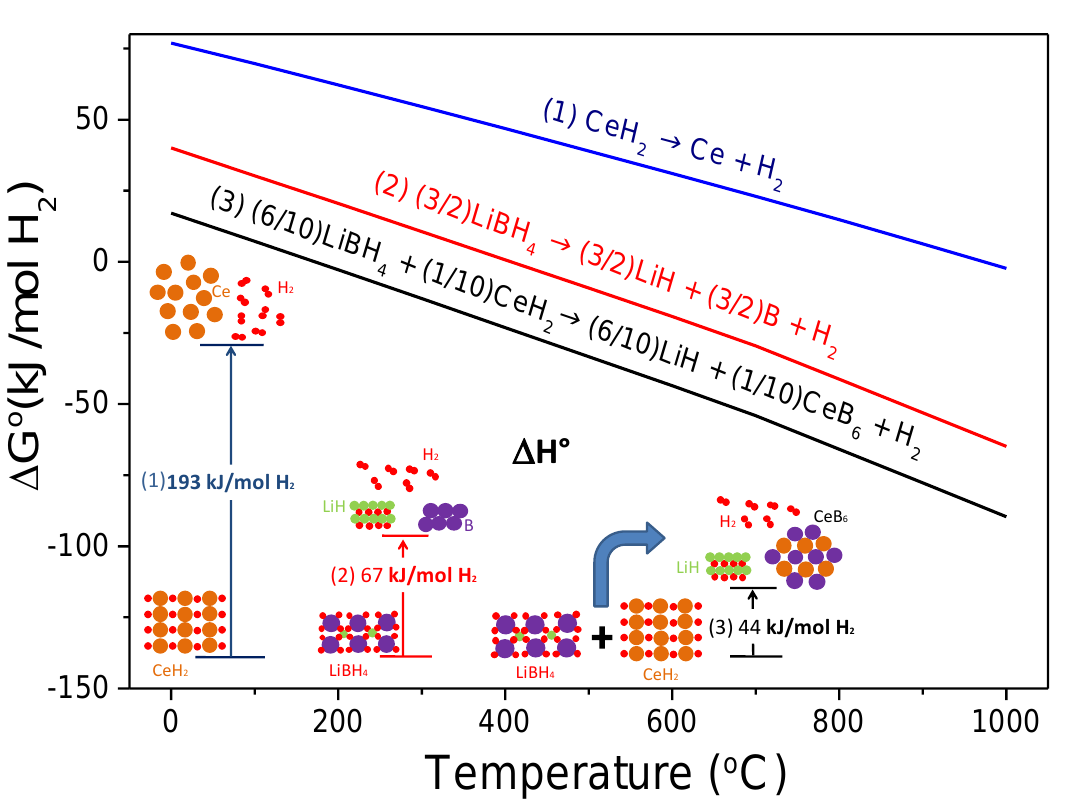
Figure 4. Free energy per mol of H 2 as a function of temperature and standard enthalpy of reaction of the hydride system 6LiBH 4 + CeH 2 .